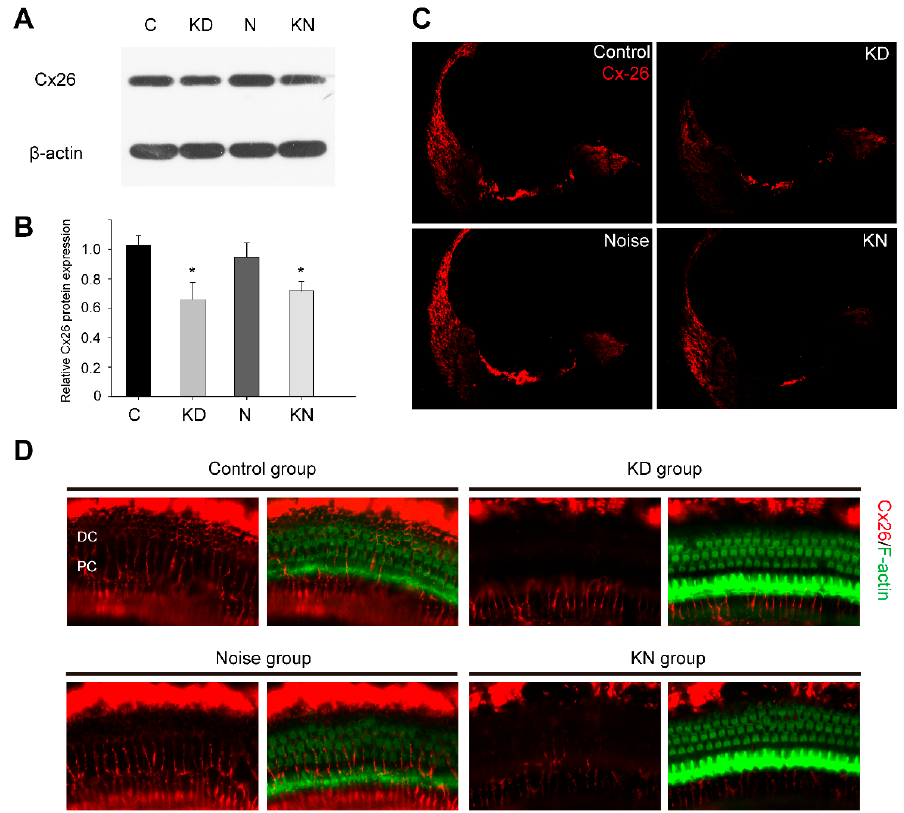
Figure 1. Connexin26 deletion in conditional connexin26 (Cx26) Knockdown (KD) mice after noise exposure. Summary of Cx26 expression in control and experimental groups. ( A , B ) Western blot and histogram detecting Cx26 in the cochleae of control, KD, noise and knockdown+noise groups (KN groups) at P30 ( n = 4 in each group); ( C ) Immunolabeling of Cx26 ( red ) in the cochlear sections of control and different experimental groups at P30; ( D ) Immunolabeling of Cx26 ( red ) and phalloidin ( green ) in flattened cochlear preparations of control and experimental groups at P30. There was an obvious Cx26 reduction in Deiter and Pillar cells of KD and KN mouse groups. Abbreviations: PC: Pillar cell; DC: Deiter cell. * p < 0.05 when compared with the control group.